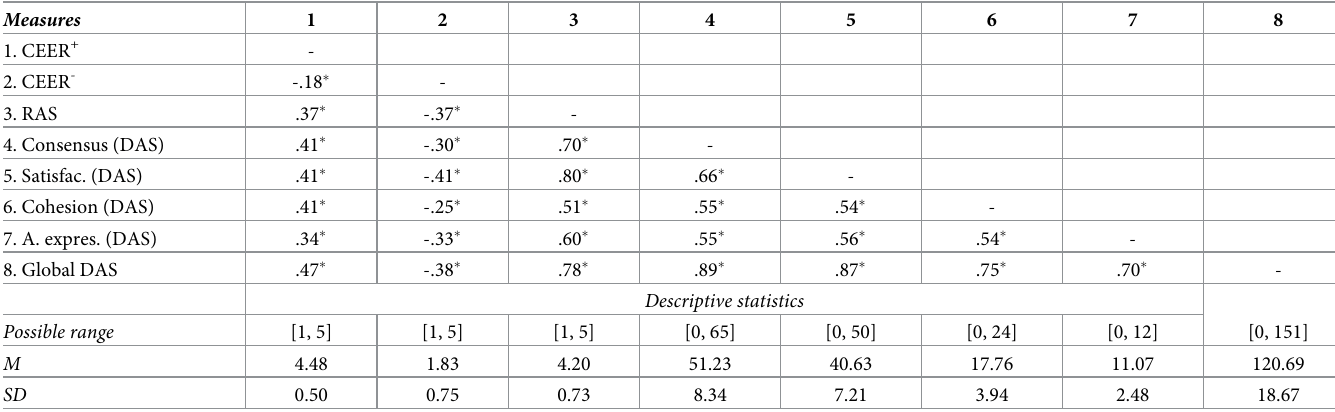
N = 528. Spearman correlations are shown. CEER + = Positive Couples Extrinsic Emotion Regulation; CEER - = Negative Couples Extrinsic Emotion Regulation; RAS = Relationship Assessment Scale; DAS = Dyadic Adjustment Scale; Satisfac. = Satisfaction; A. expres. = Affectional expression. � p <